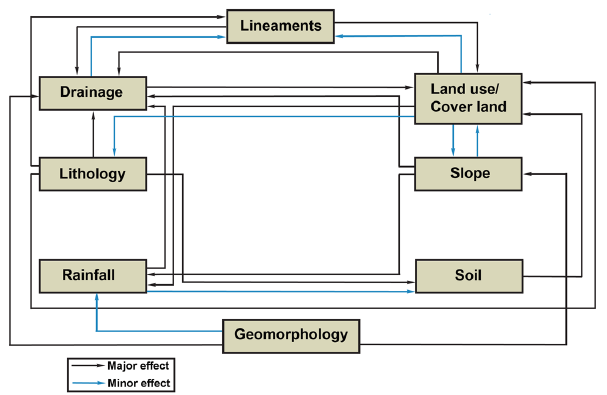
Figure 5. Interrelationships between multiple factors influencing groundwater recharge.